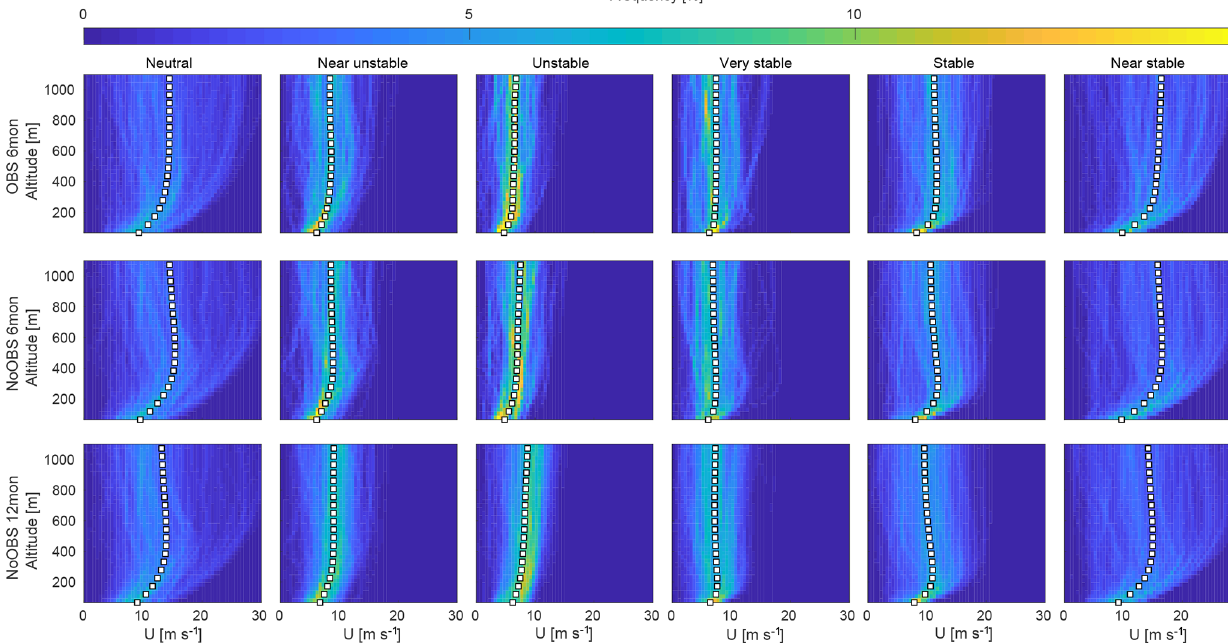
Figure 9. Wind speed U , frequency of occurrence and mean (white square) categorized by atmospheric stability according to Obukhov length L (see Table 1) for 6-month OBS (top panels), 6-month NoOBS (center panels) and 12-month NoOBS (bottom panels). Table 1. Stability classes according to Obukhov length calculated based on WRF results (Floors et al., 2011). Stability